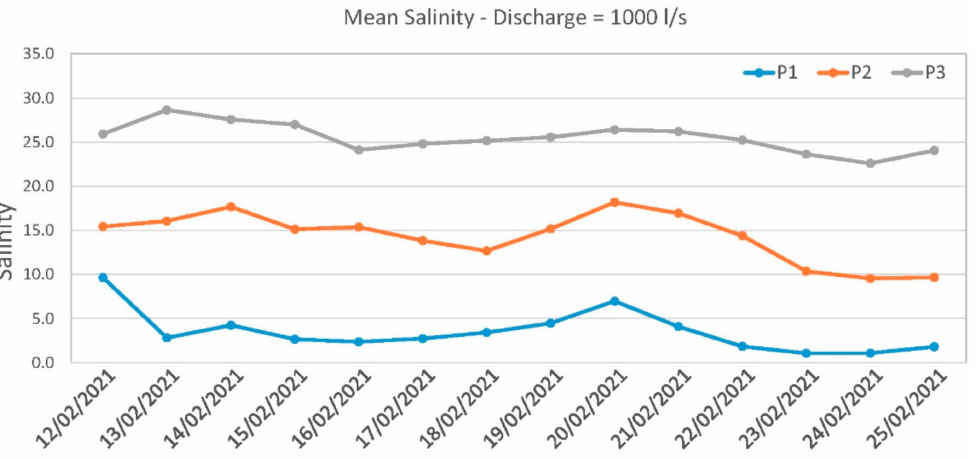
Figure 8. Daily mean salinity acquired from moored probes for the period 12–25 February 2021 with discharge of fresh water of 1000 ls − 1